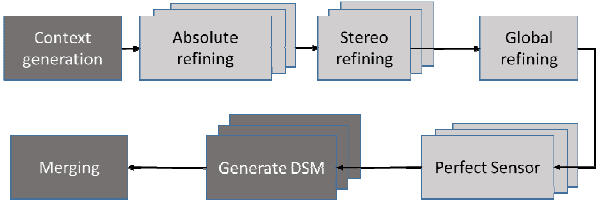
Figure 3. DSM production line (steps in dark grey are